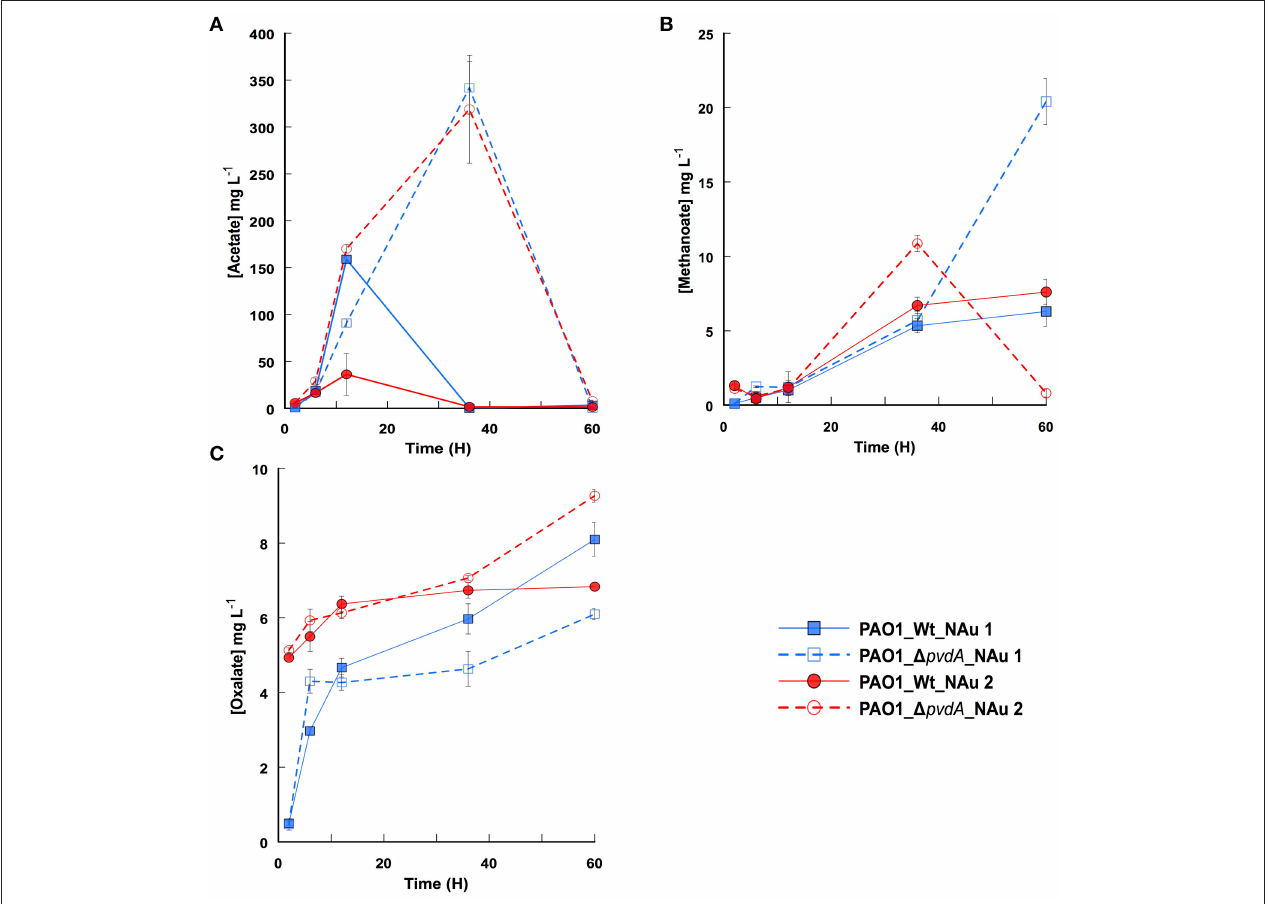
FIGURE 3 | Time profiles of acetate (A), methanoate (B), and oxalate (C) production by PAO1 WT (filled symbols) and PAO1 1 pvdA (empty symbols) in a medium containing NAu-1 (squares) and NAu-2 (circles). Values are means of triplicate